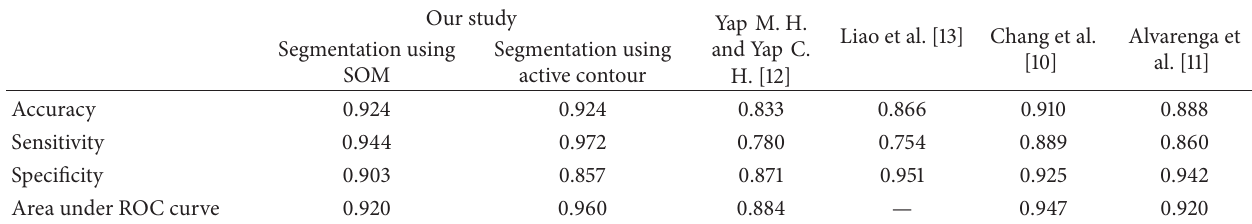
Table 6: Performance of other